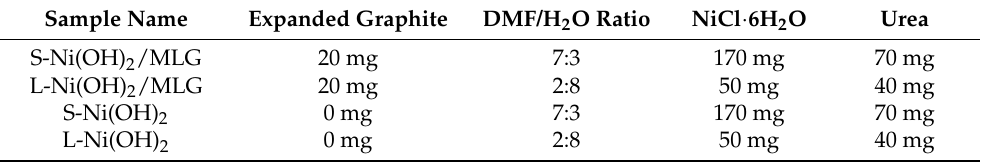
Table 1. Masses of raw materials to synthesize different